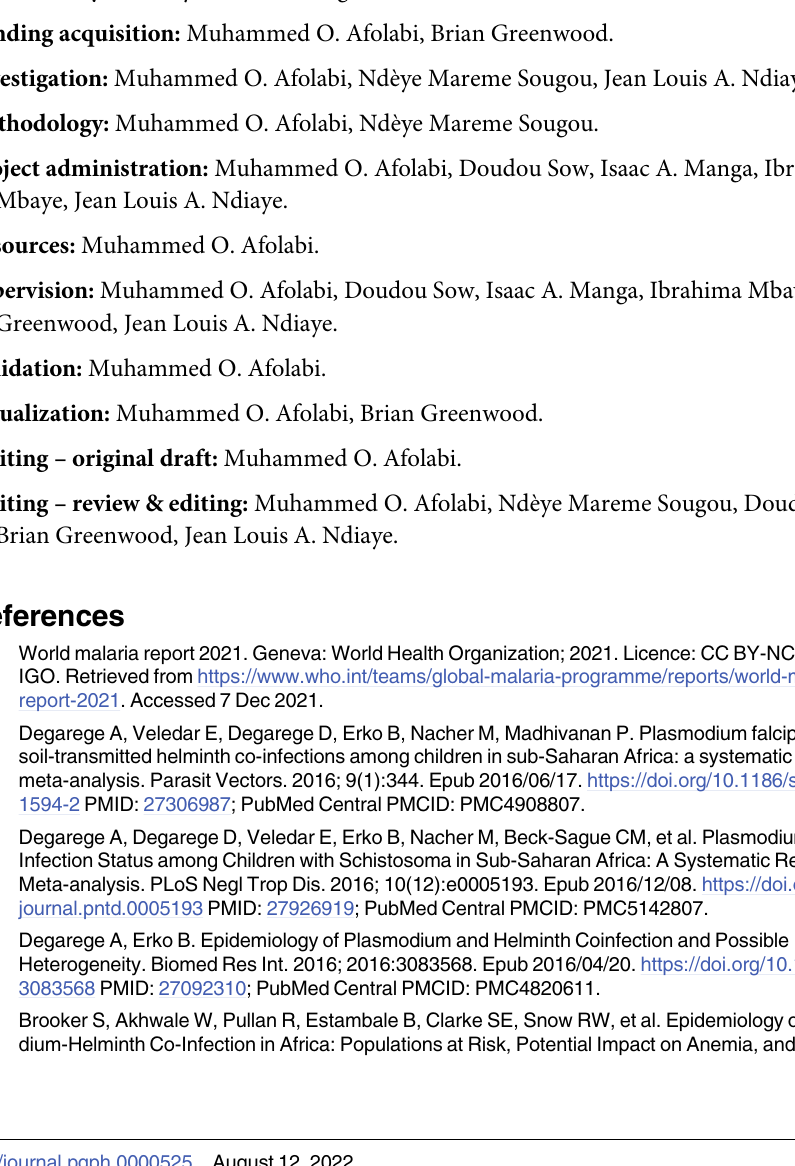
S1 Table. Interview guide used to collect qualitative data from the